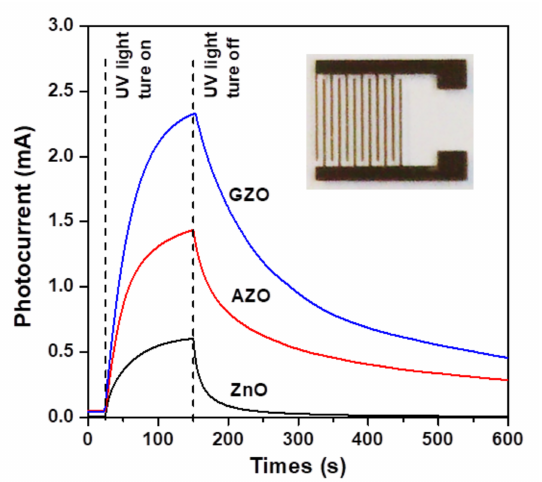
Figure 8. Photoresponse of the ZnO-based MSM photodetectors at a bias of 5 V under illumination with UVA light. The inset shows a top view optical microscope (OM) image of the